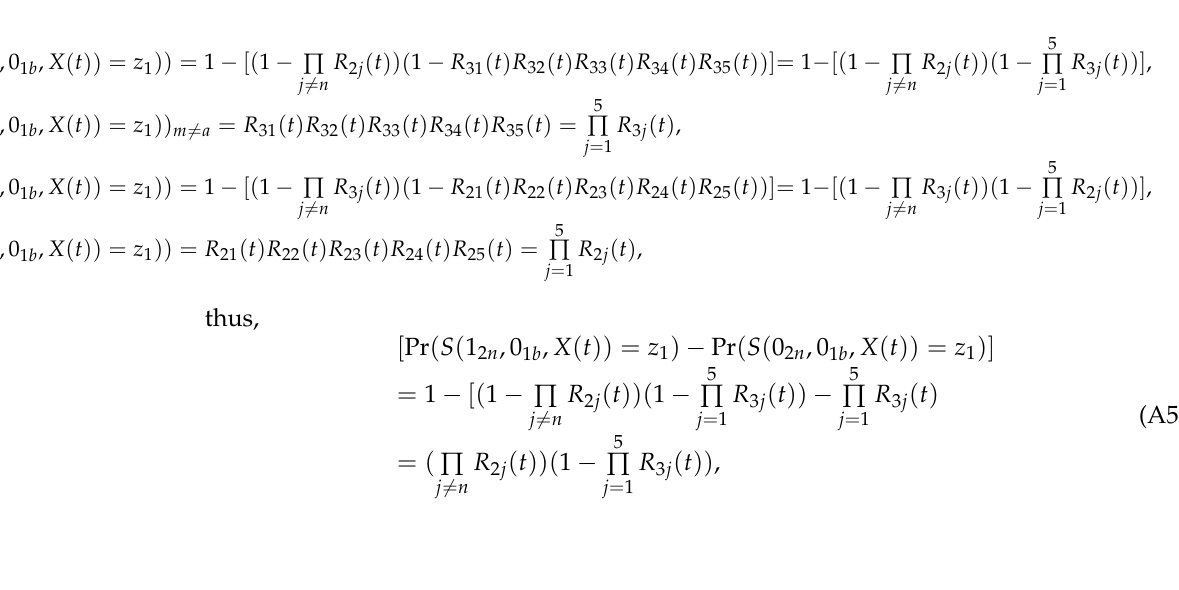
Z are in series with 1